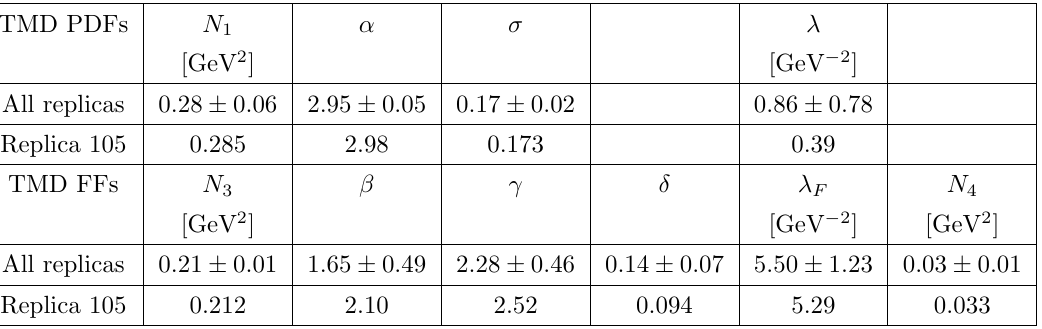
Table 1 . 68% con(cid:12)dence intervals of best-(cid:12)t values for parametrizations of TMDs at Q = 1